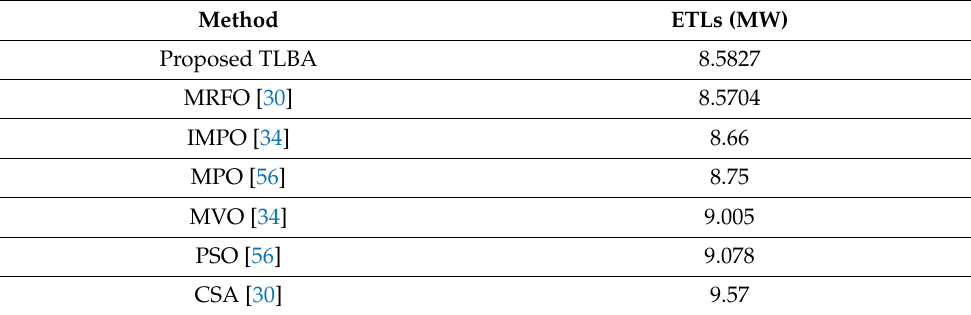
Table 5. Comparative results of the IEEE 30-bus network for the minimization of the ETLs.